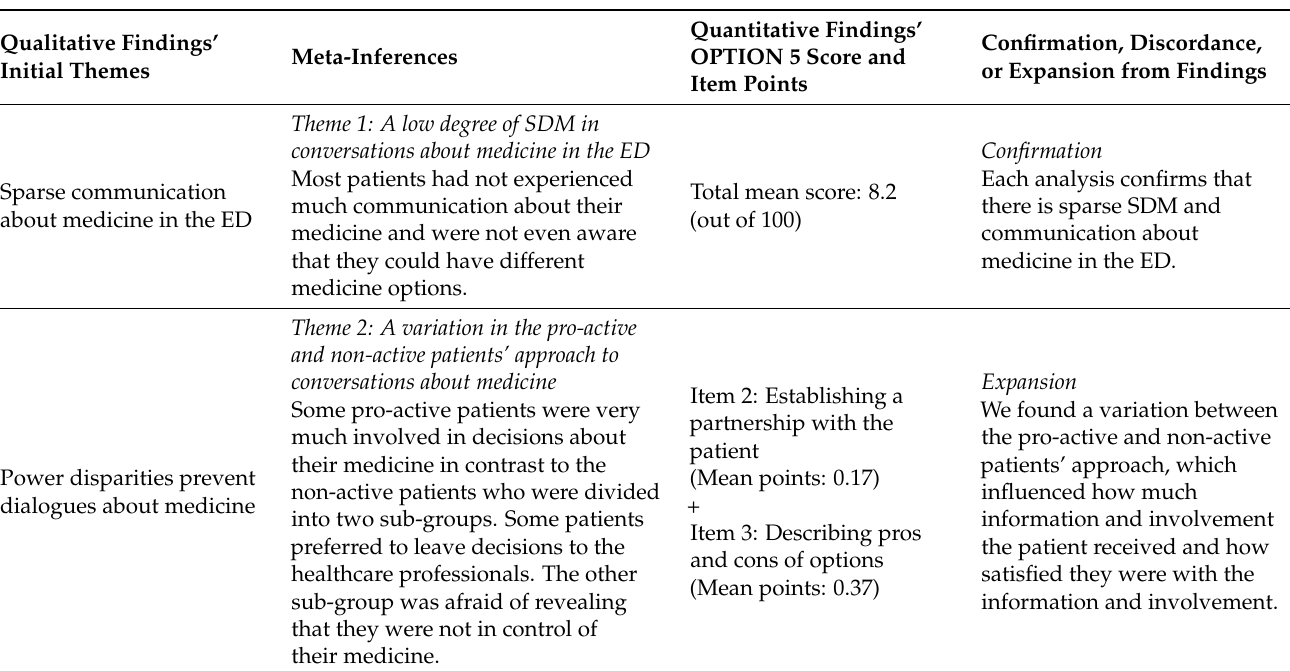
Table 5. The meta-inferences between the two